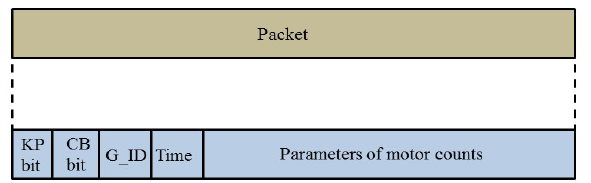
Figure 2. Architecture of